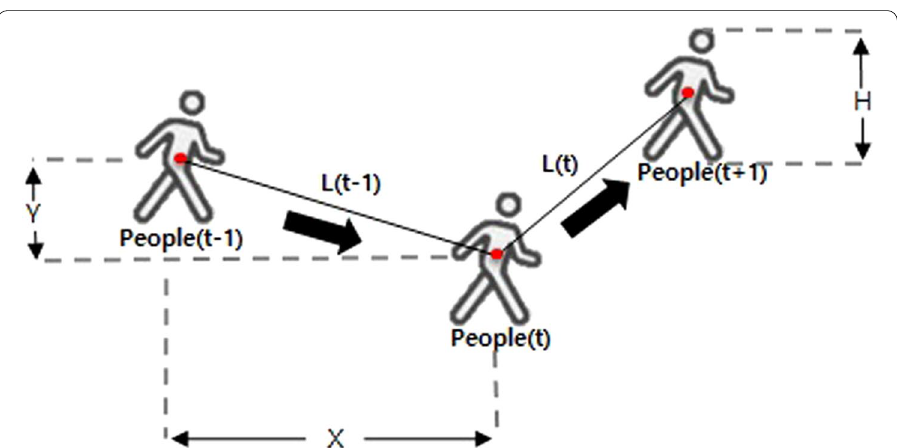
Fig. 3 Object moving distance